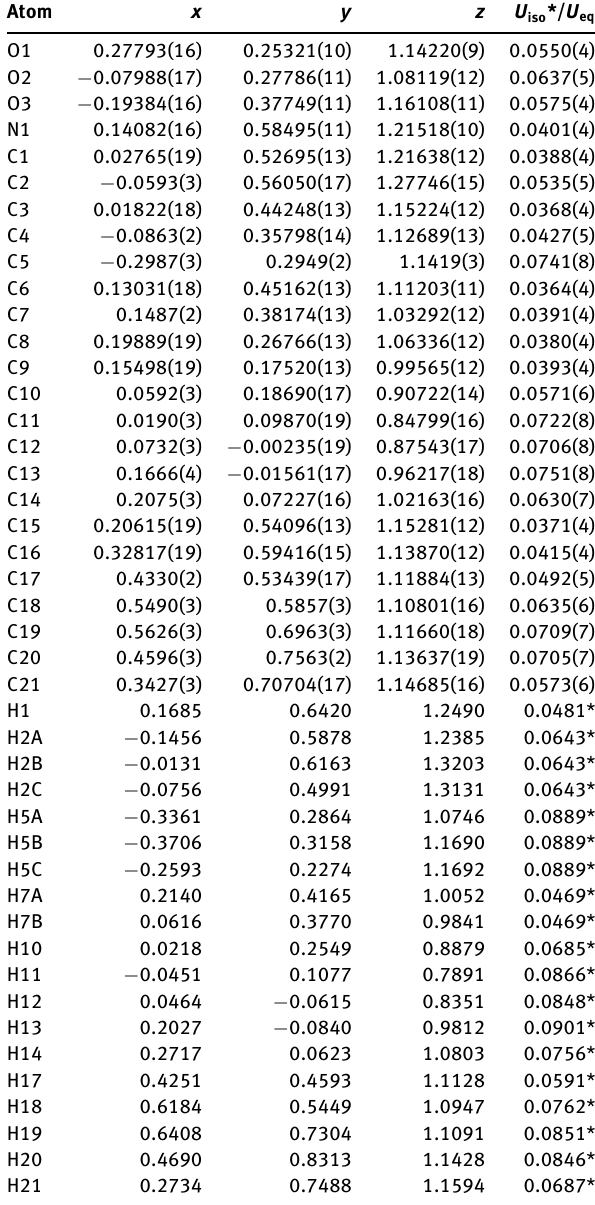
Table 2: Fractional atomic coordinates and isotropic or equivalent isotropic displacement parameters (Å 2